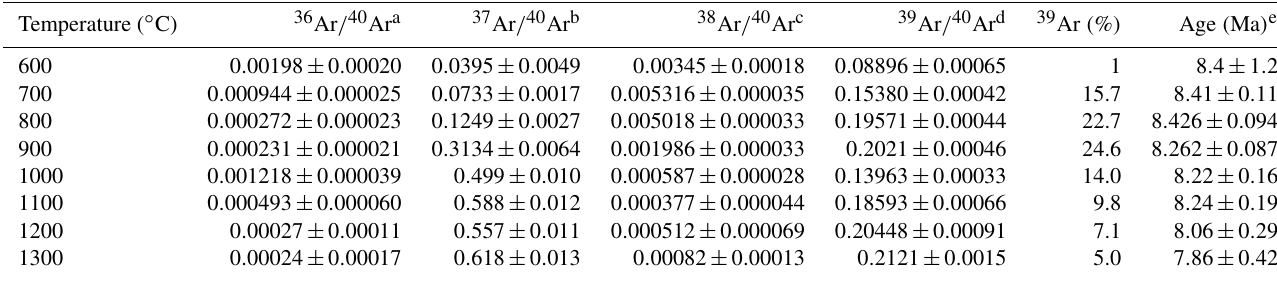
Table 3. Stepwise-heating 40 Ar / 39 Ar analyses of the volcanic matrix of the Seifu Seamount